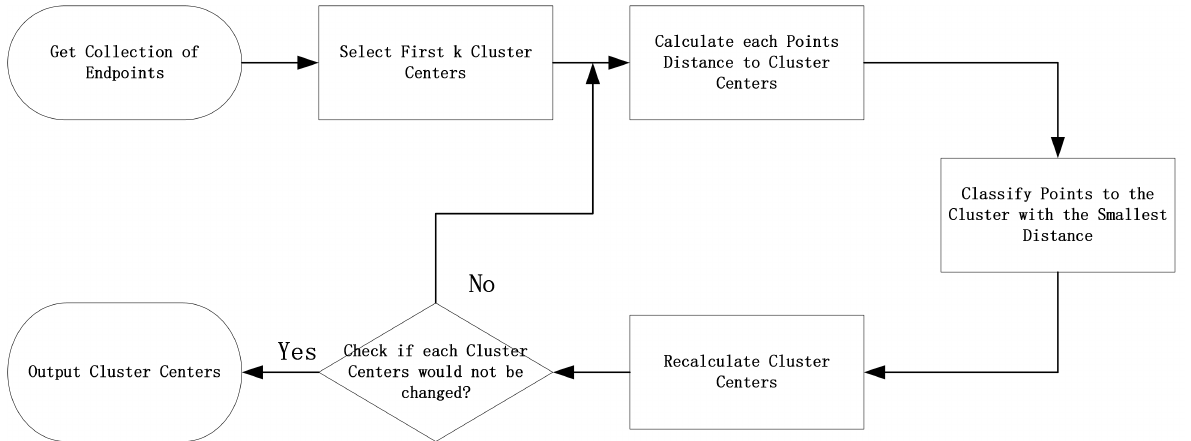
Figure 13. K-Means clustering algorithm flow.